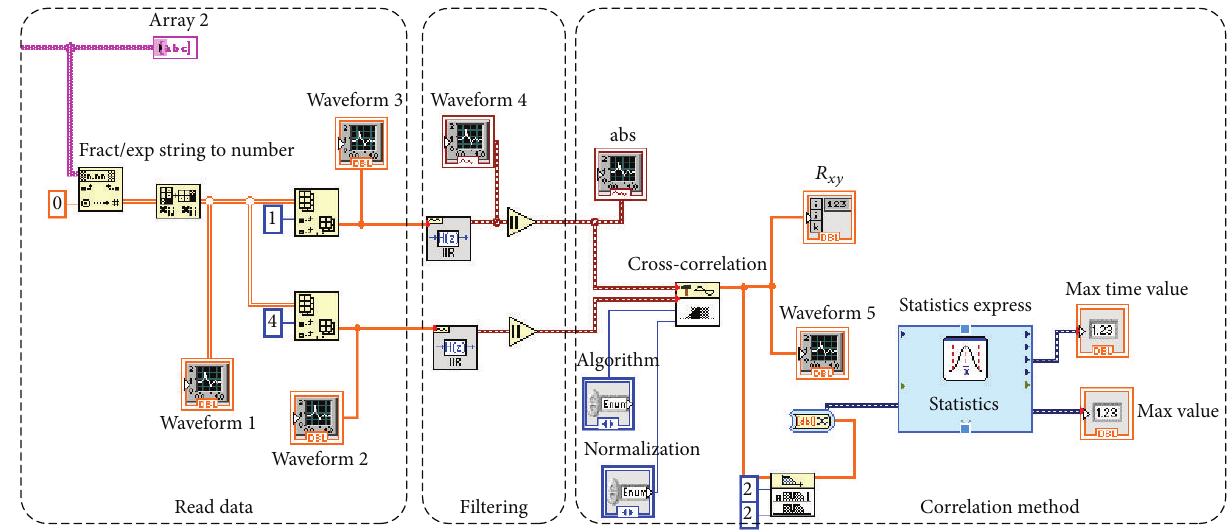
Figure 4: Labview code of correlation method.